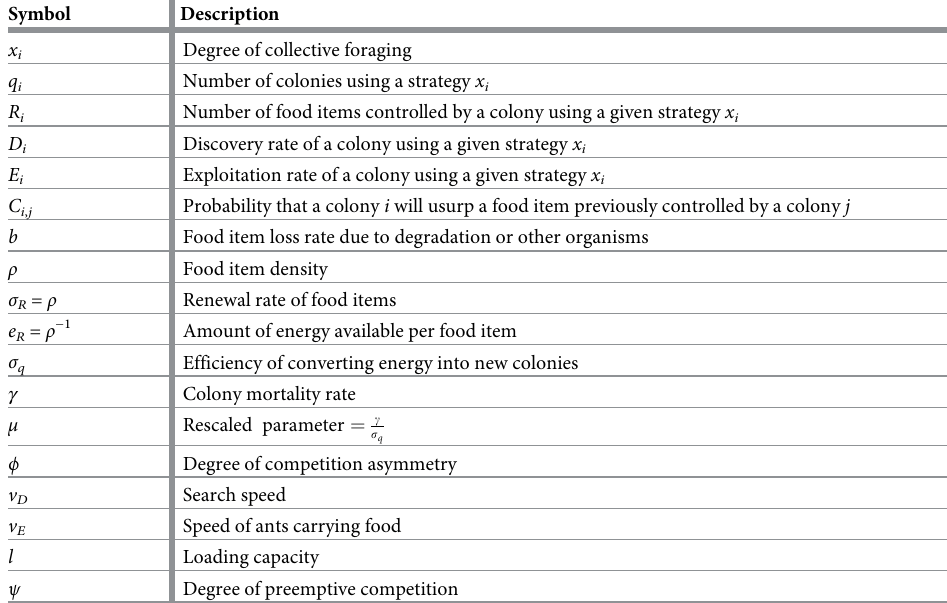
Table 1. Parameters used in the